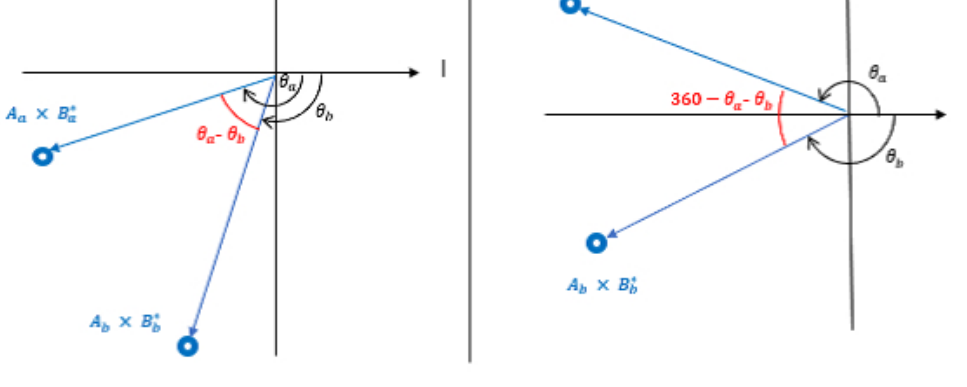
Figure 5. Calculation of the phase